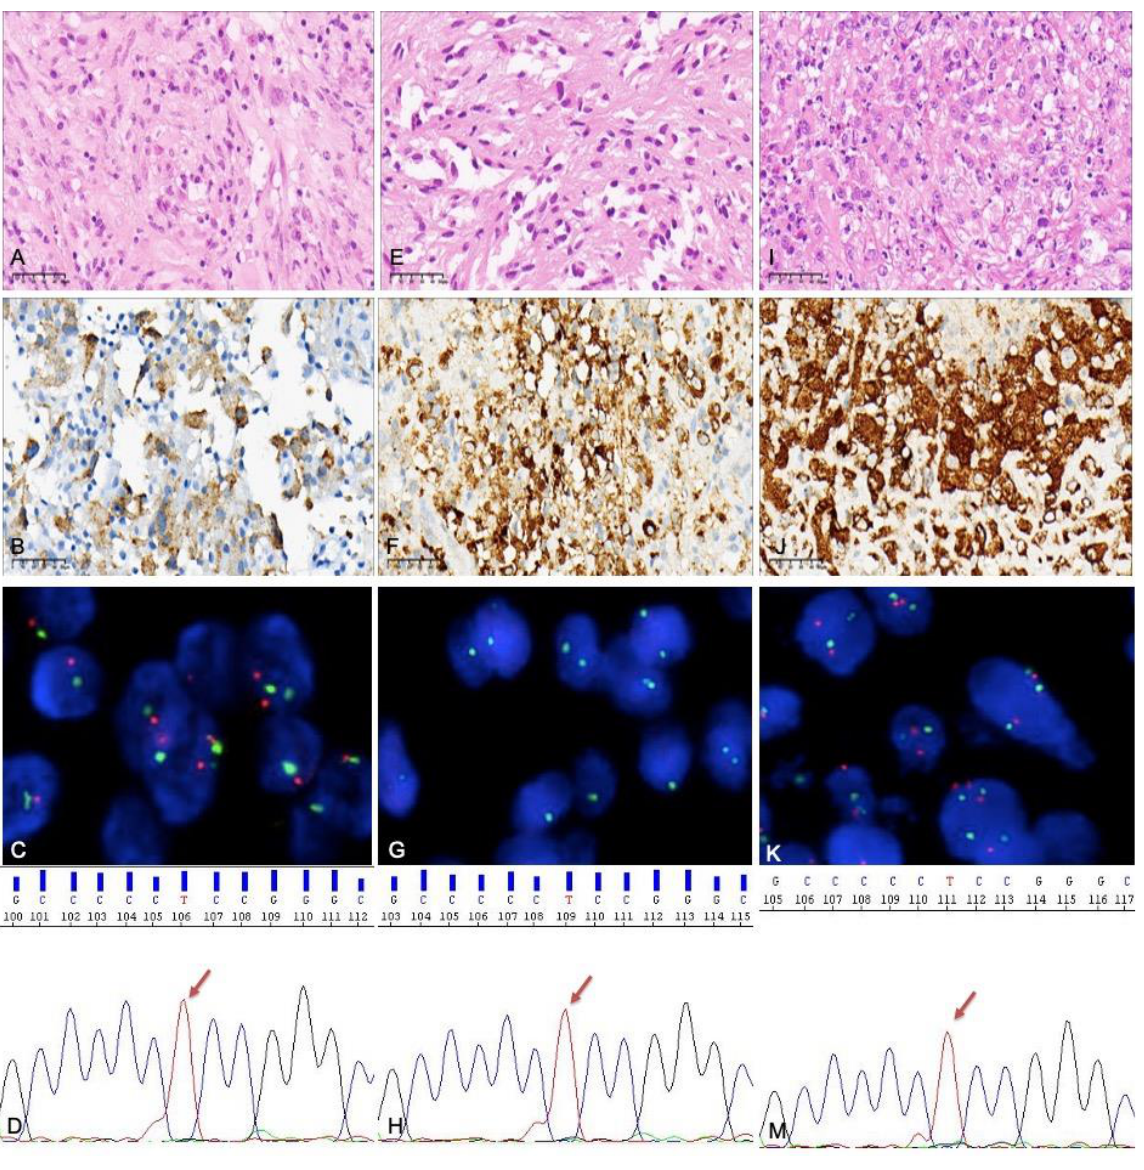
Figure 3. Histological molecular examination results for a tumor that recurred twice after incomplete excision: ( A – D ) case 19 (the primary tumor), ( E – G ) case 46 (the first relapse), and ( I – K , M ) case 53 (the second relapse). ( A ) An area composed of mostly spindle cells and some multinucleated cells. ( B ) BRAF V600E expressed by tumor cells (by immunohistochemistry). ( C ) CDKN2A identified via FISH, with no homozygous deletion. ( D ) TERT promoter mutation detected by PCR; the site was C228T. ( E ) Spindle cell areas can still be seen in the tumor with first recurrence. ( F ) BRAF V600E expressed by tumor cells. ( G ) CDKN2A homozygous deletion identified via FISH. ( H ) TERT promoter mutation; the site was C228T. ( I ) Epithelioid cells as the main component, accompanied by significant nuclear atypia. ( J ) BRAF V600E expressed by tumor cells. ( K ) There was no CDKN2A homozygous deletion. ( M ) TERT promoter mutation; the site was still C228T.